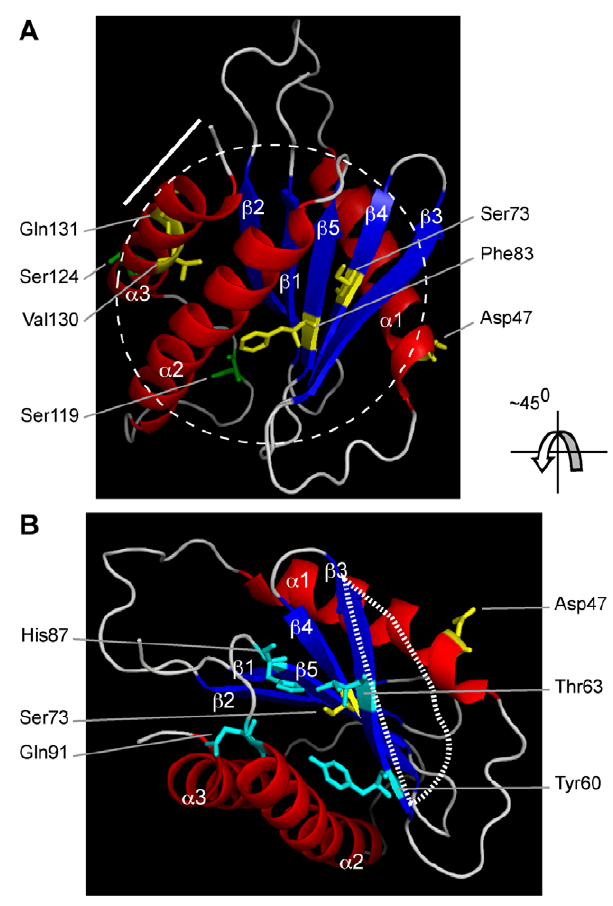
Figure 2. Three-dimensional model of SEDLIN showing loca- tions of residues involved in the mutations studied. The model is based on a published model of mouse Sedlin [2]. (A) A ribbon model of Sedlin showing the alpha helices in red, beta strands in blue and the residues involved in the missense mutations (Asp47Tyr, Ser73Leu, Phe83Ser, and Val130Asp) in yellow. The bold line indicates the 10 C- terminal amino acids that would be deleted by the nonsense SEDLIN mutation (Gln131Stop) shown in yellow. The dashed circle indicates the hydrophobic core of Sedlin. The Ser119 and Ser124 residues that were predicted to be phosphorylation sites (NetPhos2.0, MotifScan and ELM databases) are indicated in green. (B) An , 45 u rotated view of the ribbon model of Sedlin showing the SEDT-associated mutated residues Asp47 and Ser73 (yellow), in SEDT, which together with the residues Tyr60, Thr63, His67 and Gln91 (light blue) aid in forming the hydrophobic groove (indicated by dotted bar line). The alpha helices are shown in red, beta strands in blue, and the linker region in